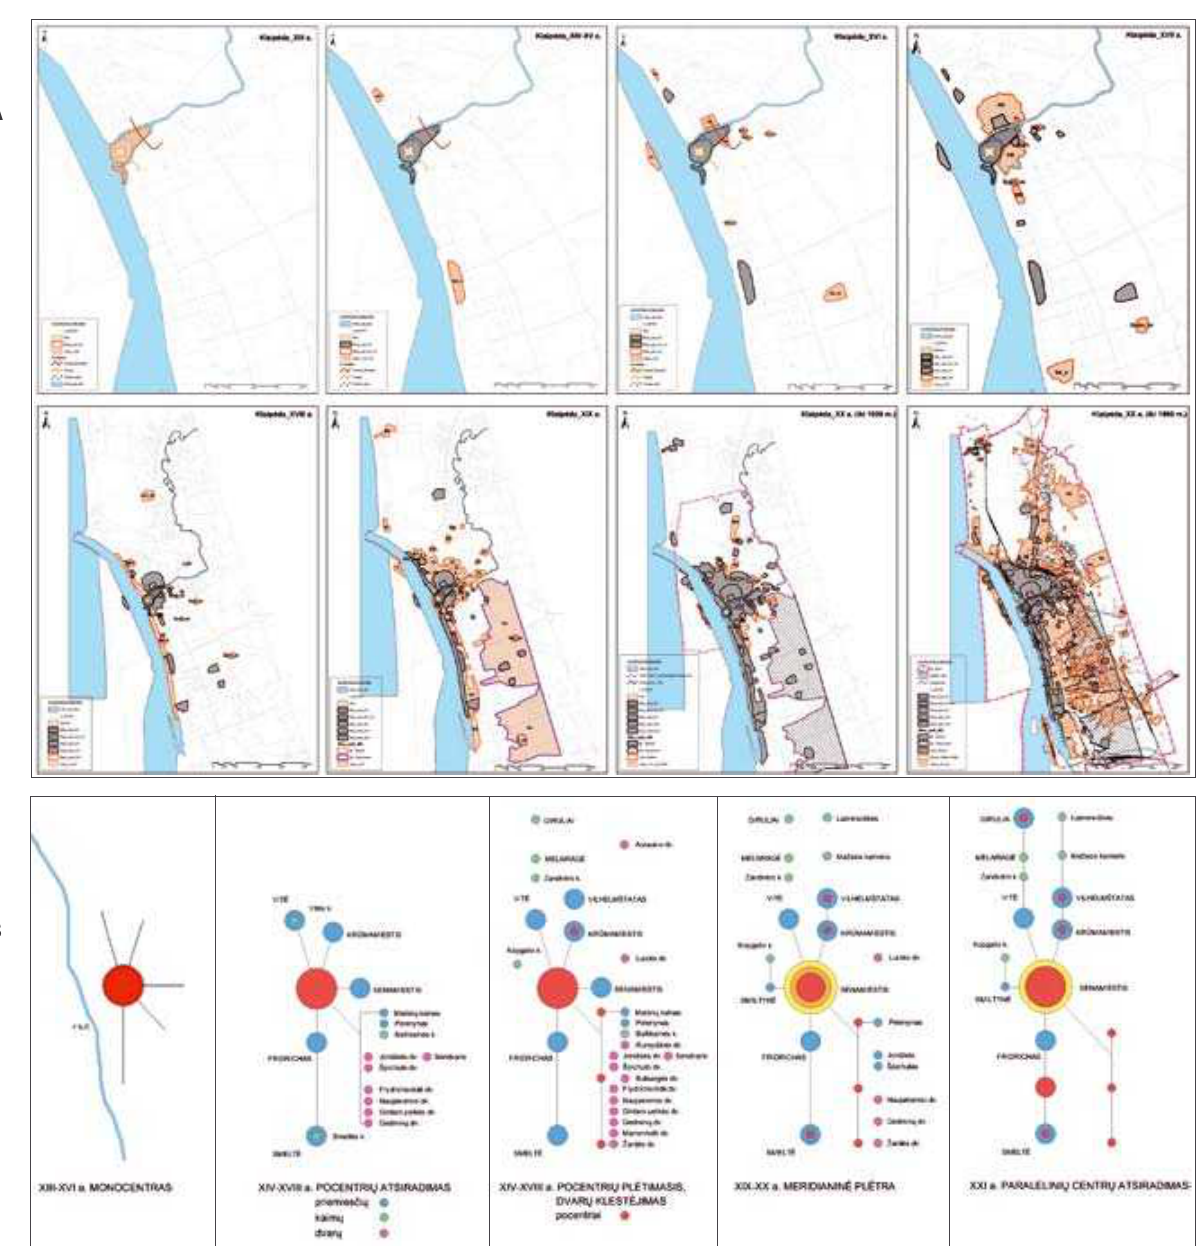
Fig. 1. Historical development of klaipėda city structure: A – development stages from 13 th to 20 th XX cent.; b – develop- ment